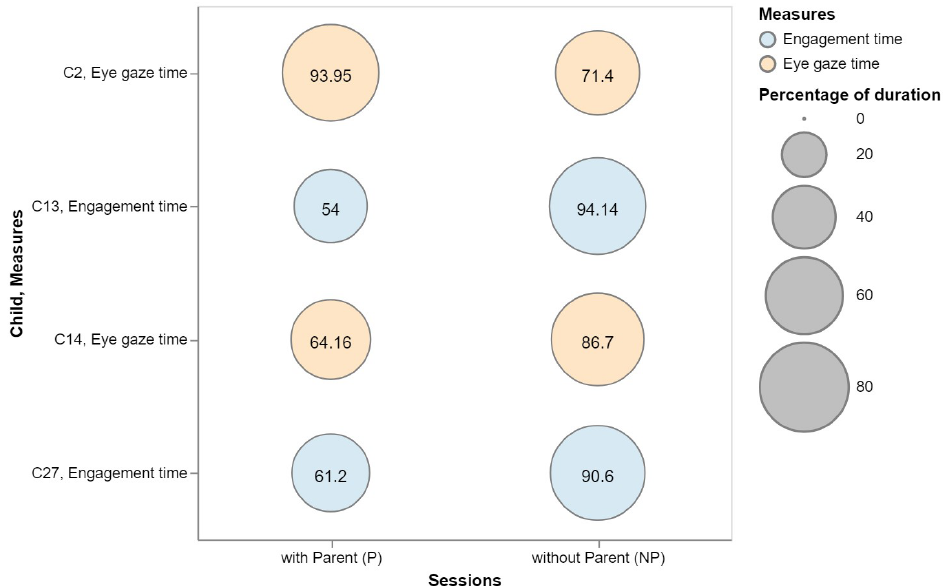
Figure 7. The significant differences of individual analyses of sessions with and without parental presence. n for p <